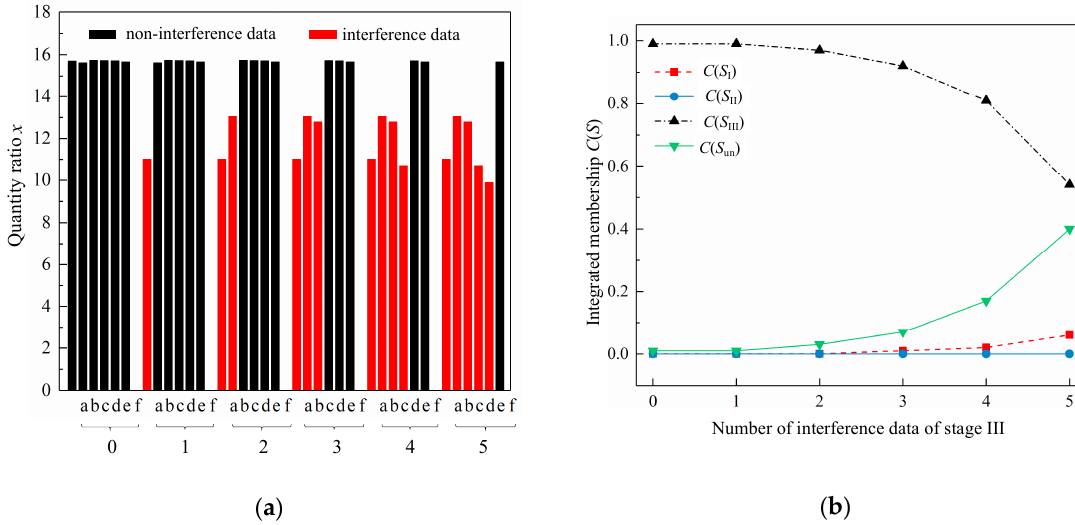
Figure 9. Performance of the model fusing di ff erent numbers of interference data of Stage III: ( a )